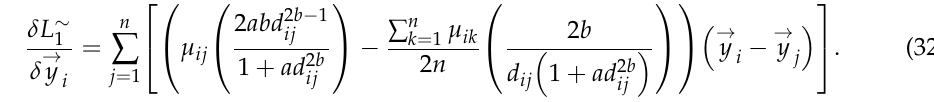
Figure 4. The dependency of curve (6) shape on the 𝑑